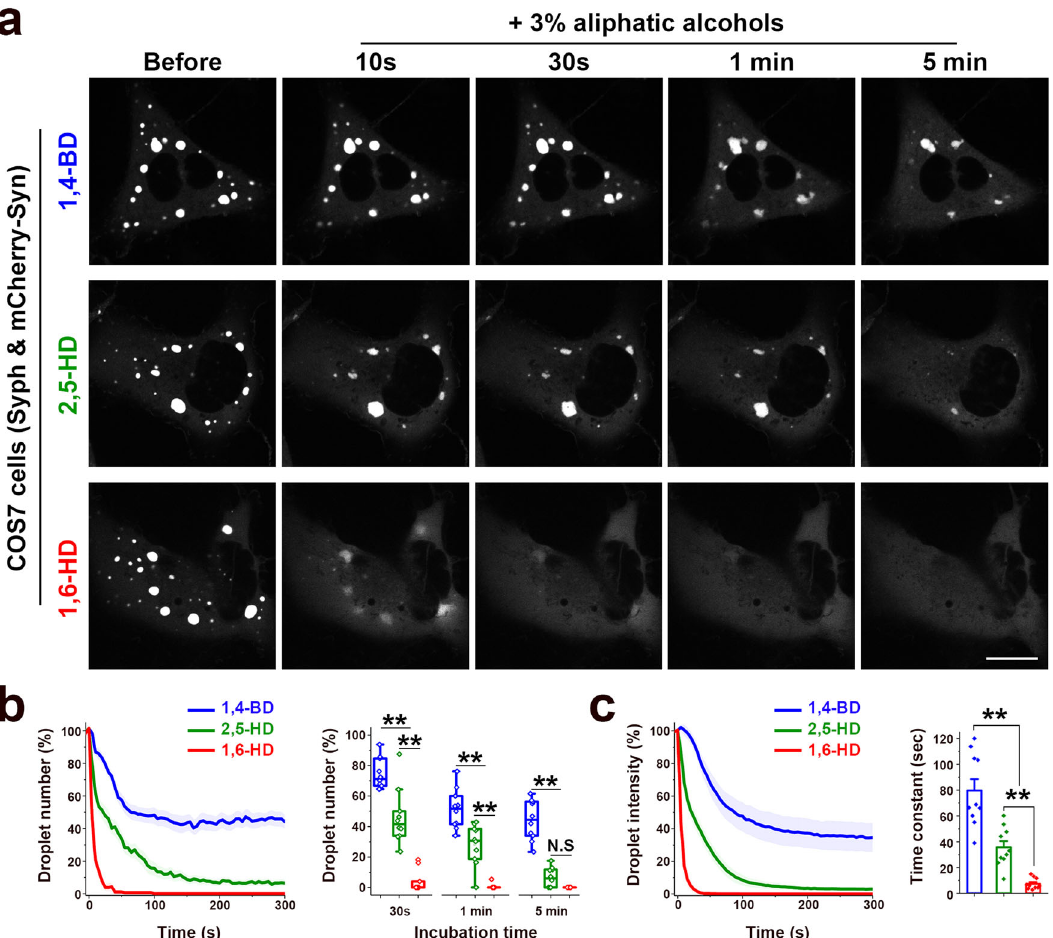
Fig. 4 Effects of different aliphatic alcohols on synaptophysin-synapsin droplets. a – c COS7 cells were transfected with synaptophysin and mCherry- synapsin and then treated with 3% aliphatic alcohols (1,4-BD: 1,4-Butanediol, 2,5-HD: 2,5-Hexanediol, 1,6-HD: 1,6-Hexanediol). a Representative time-lapse images. Scale bar = 20 μ m. b , Left: Time-dependent changes in the number of droplets. Right: Box plots show median line (midline), 25/75 percentiles (boxes), and range (whiskers) at three different time points after treatment. c , Analysis of the fl uorescence intensities of droplets after addition of aliphatic alcohols. Left: Integrated intensity of droplets at each timepoints were normalized to the initial value (before treatment). Right: The decay time constant ( τ ) was calculated by fi tting the decay trace with a single exponential function. Values are means± SEM; N.S., not signi fi cant; ** p < 0.01 by one-way ANOVA and Tukey ’ s HSD post hoc test. n = 10 independent experiments for each groups. p values ( b ): 8.09563E-5 (1,4-BD vs. 2,5-HD at 30 s), 0 (1,4-BD vs. 1,6-HD at 30 s), 1.29319E-7 (2,5-HD vs. 1,6-HD at 30 s), 1.53526E-4 (1,4-BD vs. 2,5-HD at 1 min), 0 (1,4-BD vs. 1,6-HD at 1 min), 1.47736E-5 (2,5-HD vs. 1,6-HD at 1 min), 0 (1,4-BD vs. 2,5-HD at 5 min), 0 (1,4-BD vs. 1,6-HD at 5 min) and 0.214 (2,5-HD vs. 1,6-HD at 5 min). p values ( c ): 4.09977E-5 (1,4-BD vs. 2,5-HD), 0 (1,4-BD vs. 1,6-HD), and 0.00553 (2,5-HD vs.